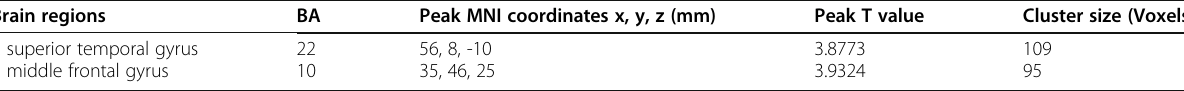
Table 5 Regions showing interaction effects of tinnitus and migraine on CBF Brain regions